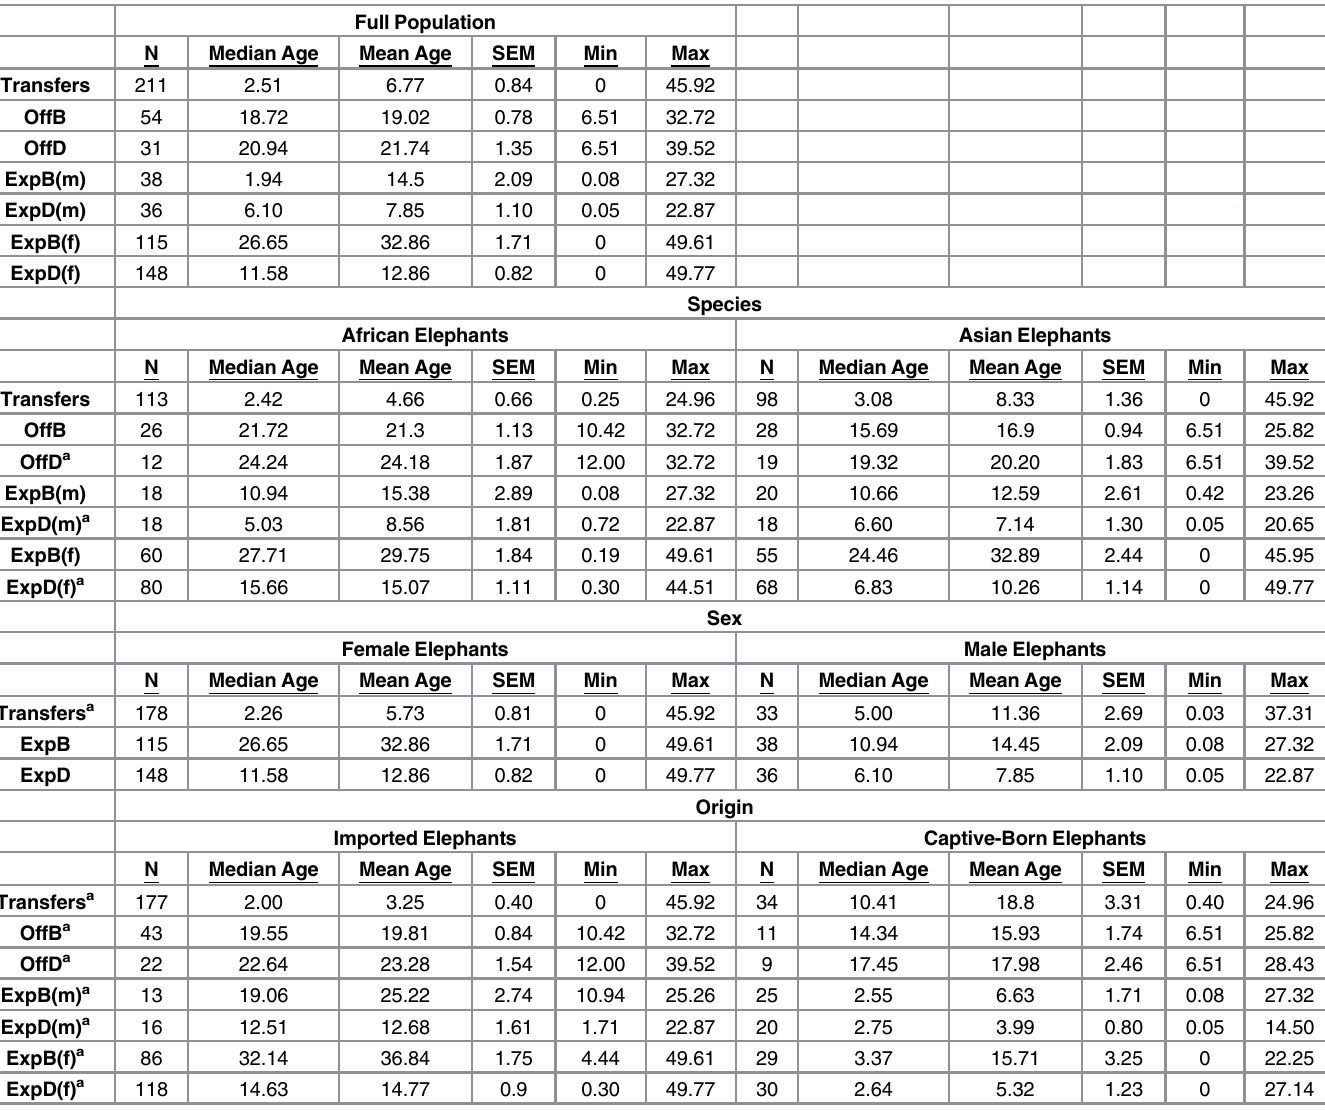
Table 7. Summary of age (in years) at first recorded event exposure using Kaplan-Meier analysis including, number of elephants (N) included in the analyses, mean, SEM and